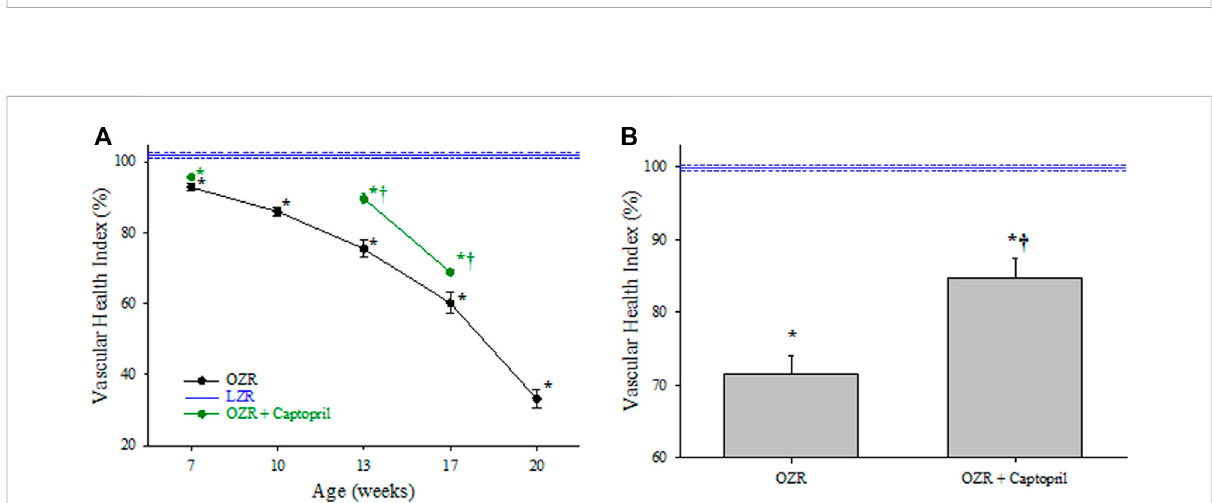
FIGURE 5 Data describing the 3-parameter determination of Vascular Health Index (VHI) within the cerebral microcirculation. Data (mean ± SE) are presented for OZR over the age ranges of the present study with and without chronic intervention with captopril administration (Panel (A) ). Panel (B) presentstheaggregateVHIfromOZR,withandwithoutcaptopriladministration,whereallageshavebeencompiledintoonedatapoint.VHIfrom LZR is set to 100%, by de fi nition. * p < 0.05 vs. LZR at that age; † p < 0.05 vs. untreated OZR at that age. Please see text for